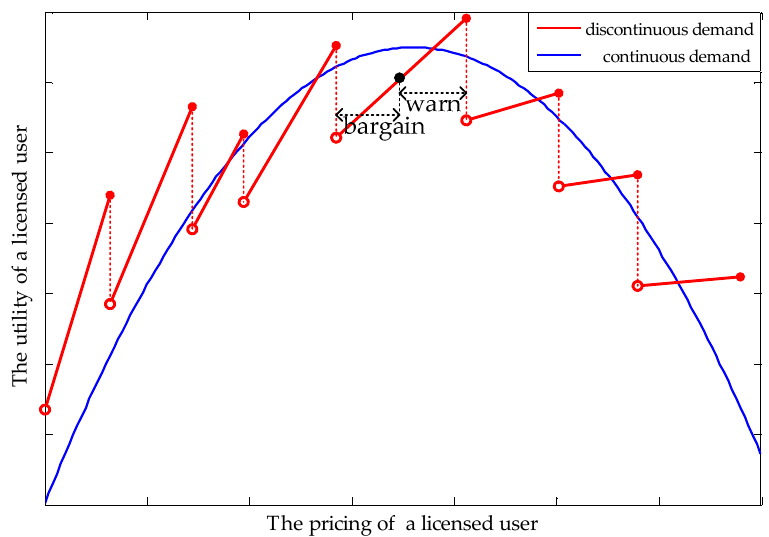
Figure 2. Utility function of a licensed user.